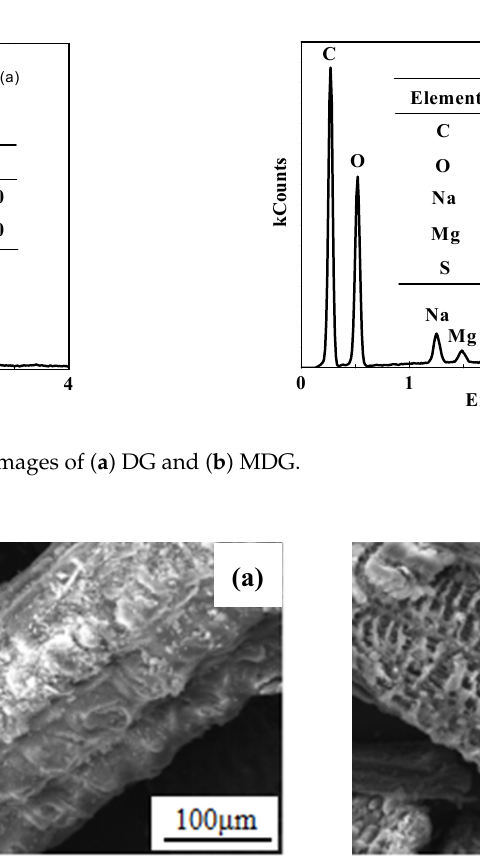
Figure 7. SEM images of ( a ) DG and ( b ) MDG. Figure 8 represents the N 2 adsorption-desorption curves and pore size distribution of DG and MDG. The N 2 adsorption-desorption curves of the adsorbent, before and after modification, both belong to the typical type-IV curve (IUPAC classification) [40,41]. It can be seen from Figure 8a that the pore diameter of DG and MDG, both exhibited uniform size distributions which are between 5~100 nm and 10~40 nm, respectively. When P/P 0 is less than or equal to 0.4, the adsorption and desorption curves of MDG overlap each other, indicating the existence of micro-pores and mono-layer adsorption (Figure 8b). When P/P 0 was greater than 0.4, the N 2 adsorption capacity of MDG increased rapidly, indicating that the pores in the adsorbent were slit pores [42,43]. The surface area and pore volume of MDG increased significantly as compared to DG, which supports the results recorded in Table 1. The surface area of MDG was 3.54 m 2 /g, showing an increase of 216% compared with DG. Table 1. The pore structure parameters of DG and MDG.